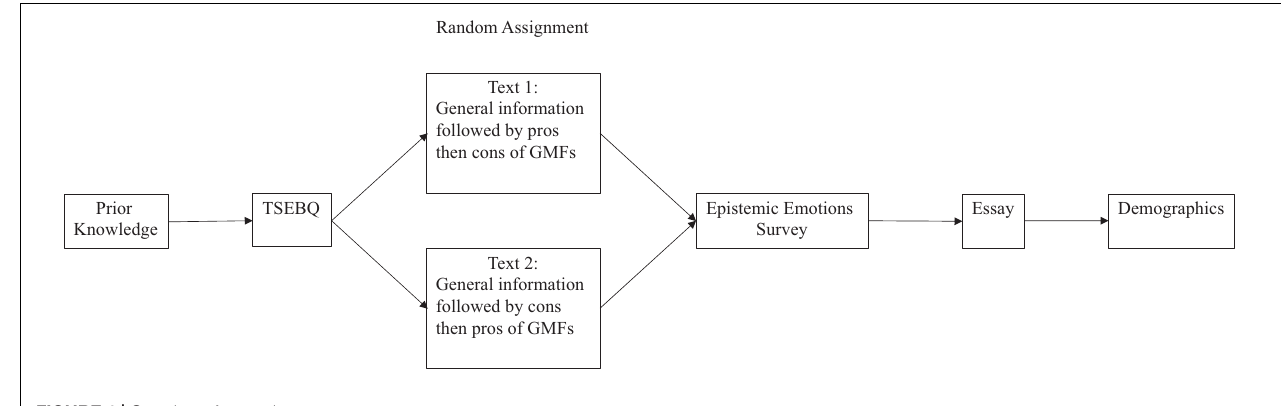
FIGURE 1 | Overview of